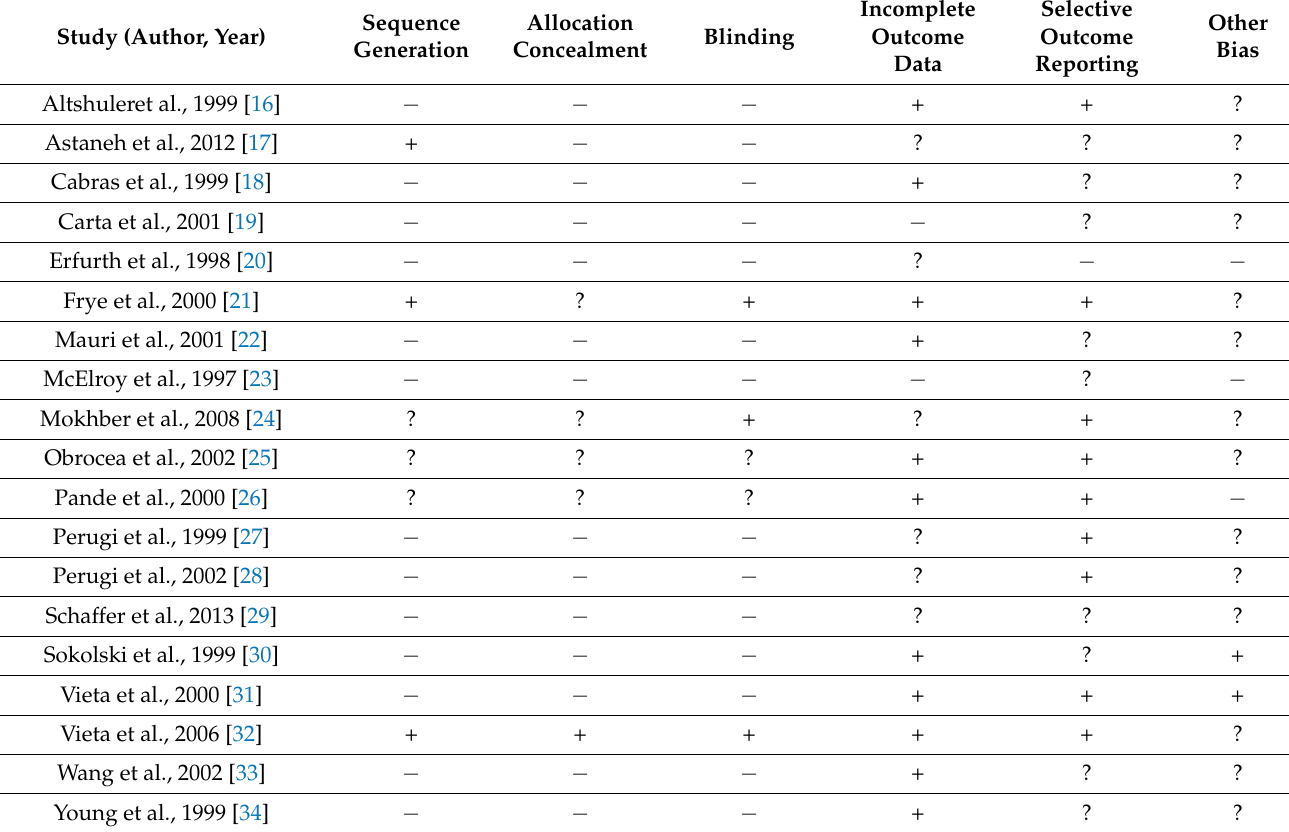
Table 2. Results of Cochrane Collaboration’s tool for assessing risk of